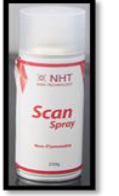
Figure 2: specialized spray to coat the metal surface